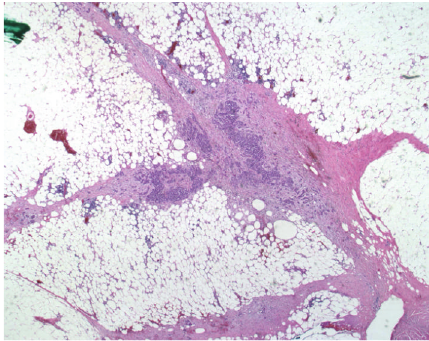
Figure 4: Fat overlying the tumour demonstrating papillary renal cellcarcinomaseedingalongthepreviouspercutaneousbiopsytract.